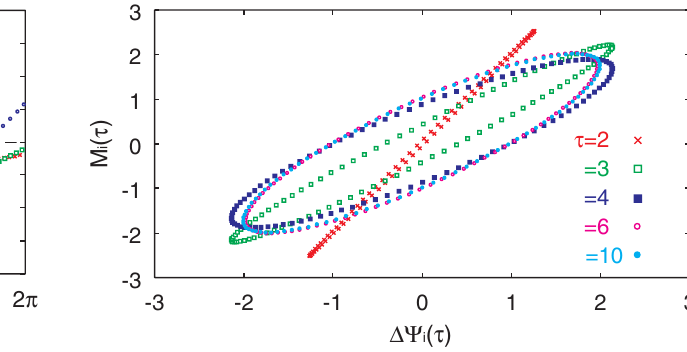
FIG. 2. (Color) Electron distributions in a phase plane of (cid:2) (cid:6) (cid:4) (cid:1) (cid:2) 0 (cid:4) (cid:3) (cid:1) (cid:2) (cid:6) (cid:4) and (cid:10) (cid:2) (cid:6) (cid:4) derived from Eqs. (12) and i i i i (13) when (cid:6) (cid:1) 9 (crosses), 10 (open squares), 11 (open circles). The arrow indicates the microbunch center which electrons are concentrated around. The initial amplitude of the within (cid:3) r radiation j a (cid:2) 0 (cid:4)j (cid:1) 3 : 79 (cid:9) 10 (cid:7) 5 is the optical field is amplified. The position of the micro- bunch center is unclear only from Fig. 2 without Eqs. (12)